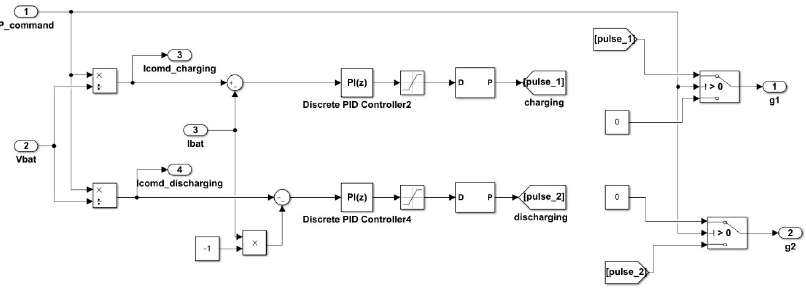
Figure 5. DC / DC converter control system. Figure 5. DC/DC converter control system. Figure 5. DC/DC converter control system.